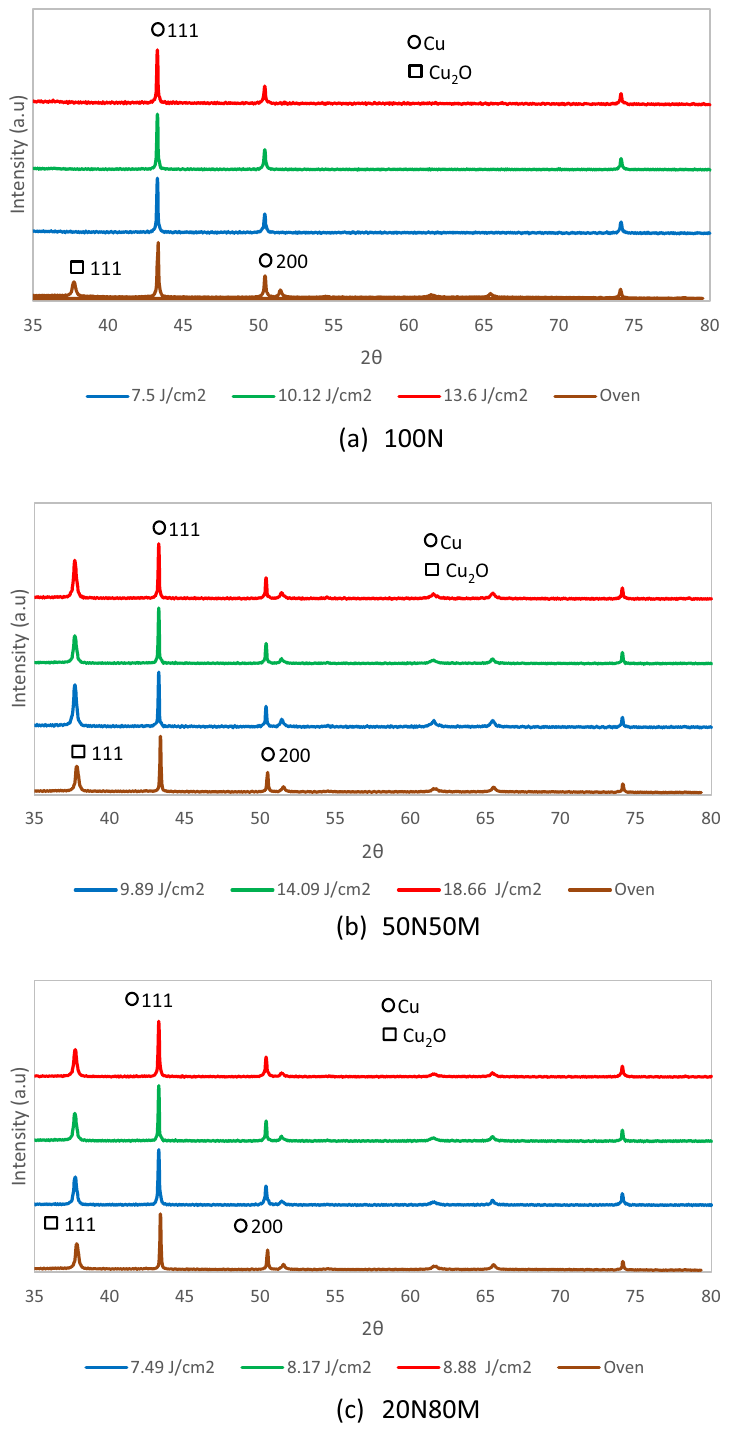
Figure 10. XRD of the ( a ) 100 N, ( b ) 50N50M & ( c ) 20N80M for the 600 µm wide